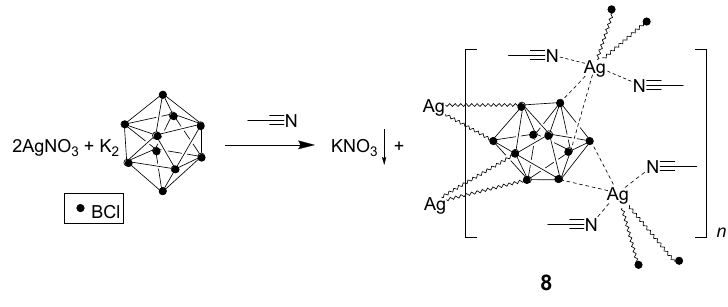
Scheme 7. Synthesis of complex 8